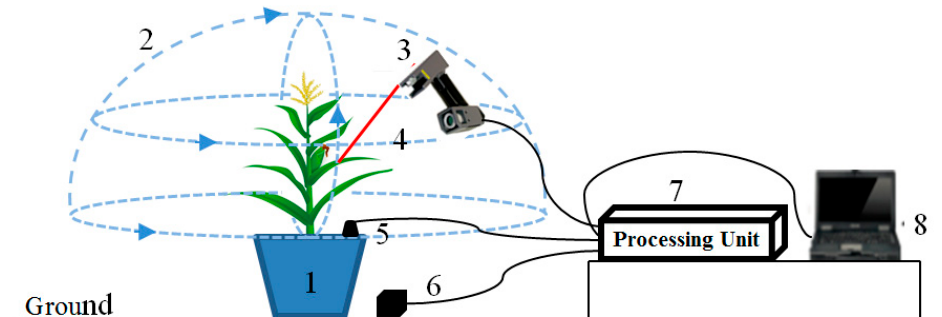
Figure 1. Schematic diagram of the data acquisition process. (1) Maize plant; (2) Scan range; (3) Wand; (4) Laser scanning line; (5) The receiver; (6) The transmitter; (7) Processing unit; (8) Laptop.